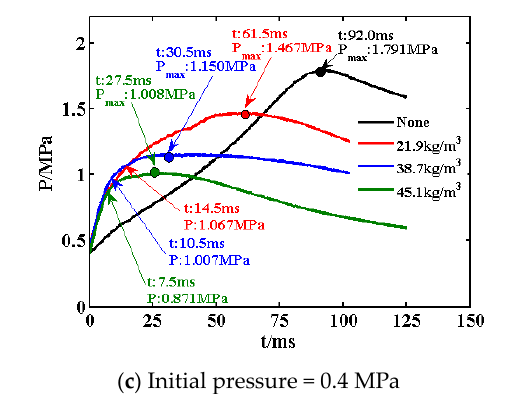
Figure 4. Time history of in-cylinder pressures at initial pressures of 0.2 MPa, 0.3 MPa and 0.4 MPa.